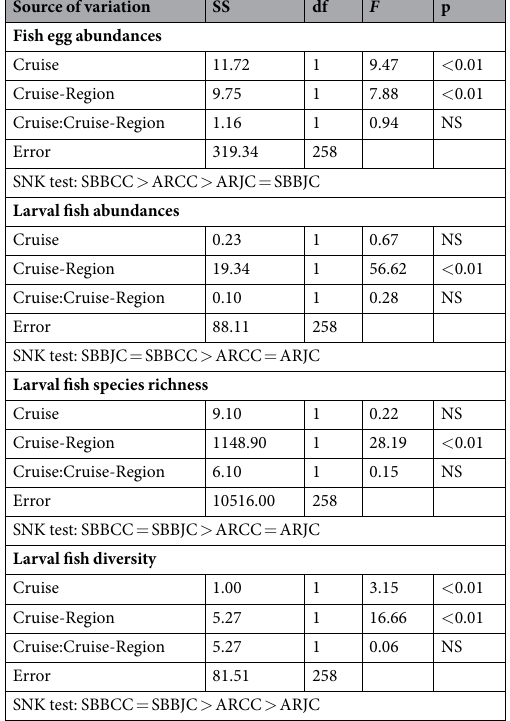
Table 1. Results of the two-way ANOVA used to test for the differences in ichthyoplankton abundance, larval fish species richness and larval fish diversity among cruises (CAREVA cruise: CC and JUREVA cruise: JC) and cruises-regions (ARCC: Atlantic region sampled during the Careva cruise; ARJC: Atlantic region sampled during the Jureva cruise; SBBCC: southern Bay of Biscay region sampled during the Careva cruise and SBBJC: southern Bay of Biscay region sampled during the Jureva cruise). Results of the Student-Newman-Keuls (SNK) post hoc test for cruise-regions (see text for the acronyms of cruise-region) are also included. (NS: not